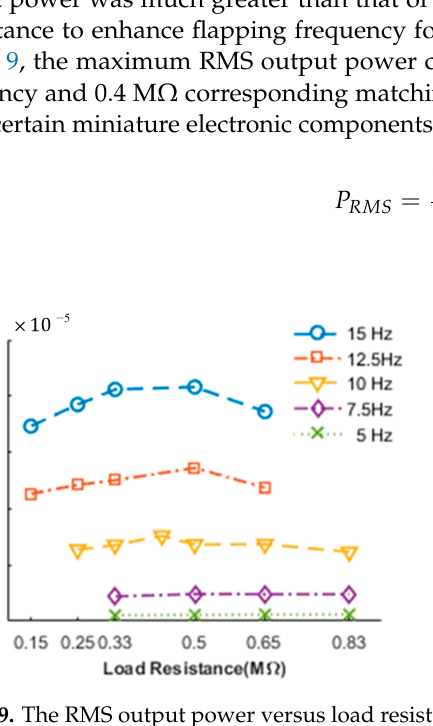
Figure 8. Payload and root mean square (RMS) voltage versus flapping frequency.